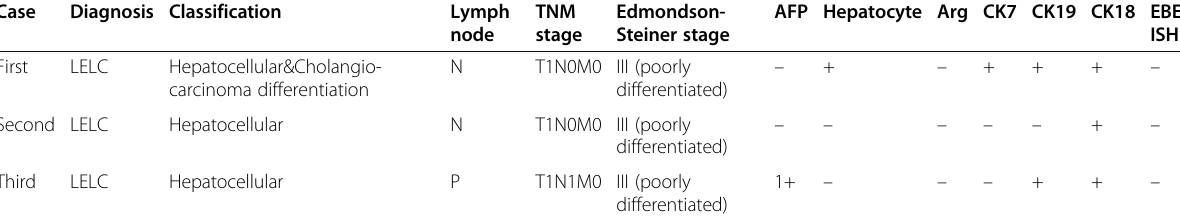
Table 2 Pathological classification and immunohistochemical markers of the 3 patients Case